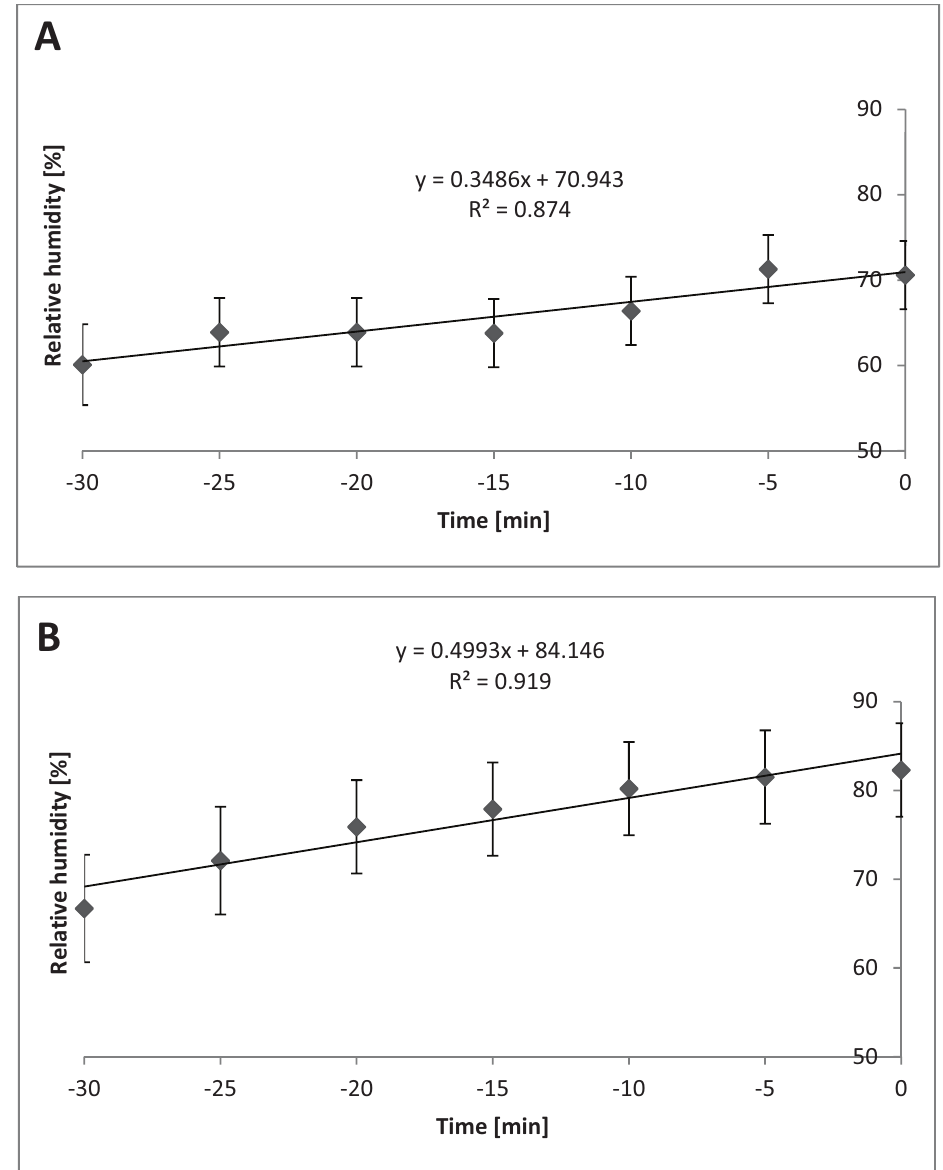
Figure 8. Relative humidity in cold weather (n = 33 trailers) in different compartments of trailer when different levels of bedding are used. ( A ) Linear change in relative humidity in top front compartment while using 0.6 m 3 bedding during cold ( P = 0.03, SEb = 0.54). ( B ) Linear change in relative humidity in bottom front compartment when using 1.2 m 3 bedding during cold ( P = 0.02, SEb = 0.70). ( C ) Linear change in relative humidity in top front compartment when using 1.2 m 3 bedding during cold ( P = 0.01, SEb = 0.84).